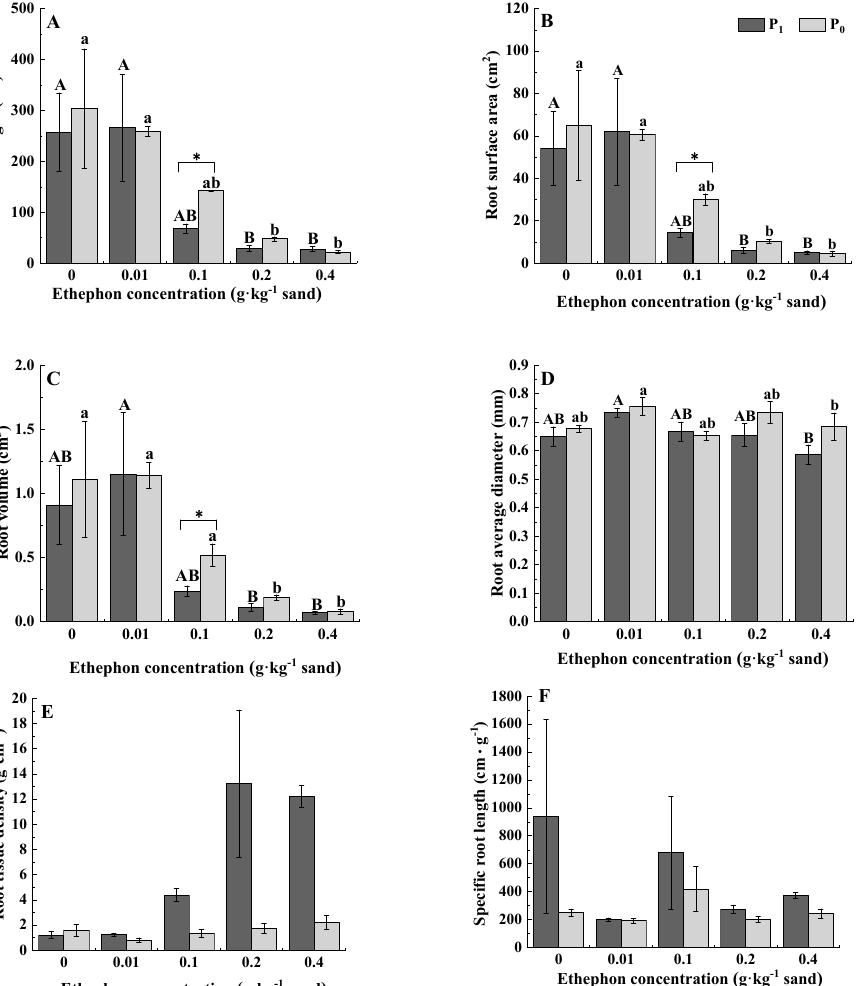
Figure 1. Differences in the root length ( A ), root surface area ( B ), root volume ( C ), root average diameter ( D ), root tissue density ( E ), and specific root length ( F ) between the two groups, namely phosphorus supply (1 mmol·KH 2 PO 4 , P 1 ) and no phosphorus supply (0 mmol·KH 2 PO 4 , P 0 ), treated with different concentrations of exogenous ethephon. Bars (mean ± standard error) accompanied by the same lowercase letter(s) are not significantly different at the 5% probability level. Different capital letters indicate significant differences between different additive concentrations under normal P supply conditions, while different lowercase letters indicate significant differences between different additive concentrations under low-P stress. * Indicates that the same additive concentration is significantly different under different P supply levels.